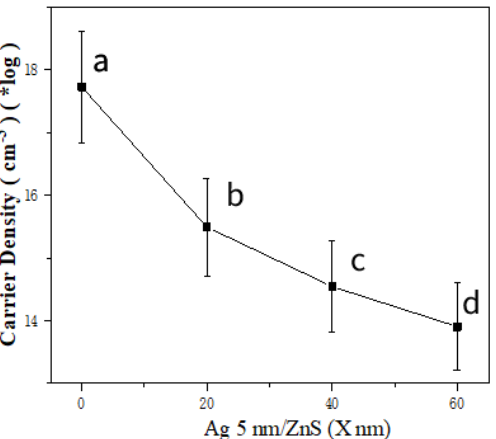
Figure 4. The dependence of electron density on ZnS thickness for Ag/ZnS (a. 0 min; b. 5 min; c. 10 min; d. 15 min) films on PS beads.